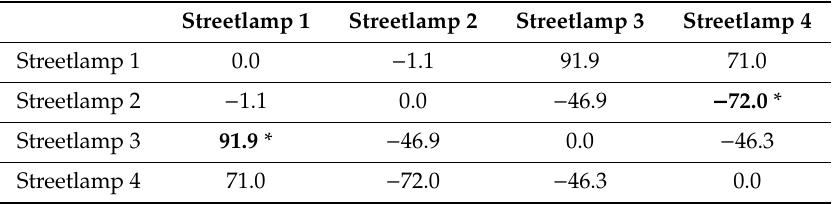
Table 8. Difference (mm) between the results listed in Table 7 and Table 8. Table 8. Di ff erence (mm) between the results listed in Tables 6 and 7.